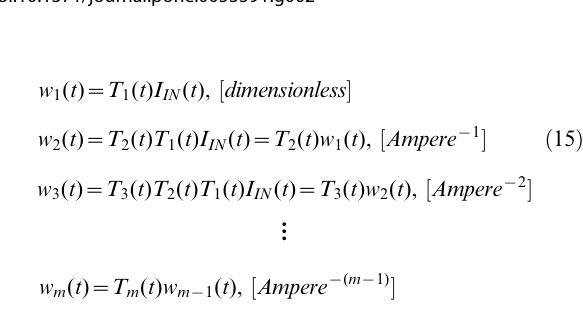
Figure 2. Schematic and symbolic representation of the dynamic TL block, which ‘‘ hosts ’’ the Bernoulli Cell. All devices have the same W/L ratio.